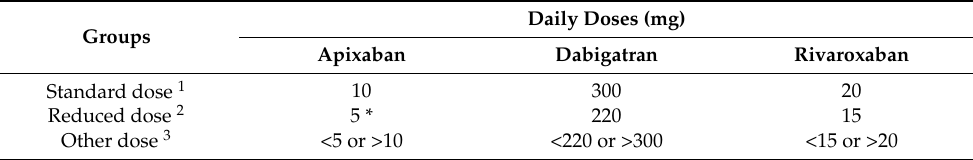
Table 1. Definition of dose groups at the index date.